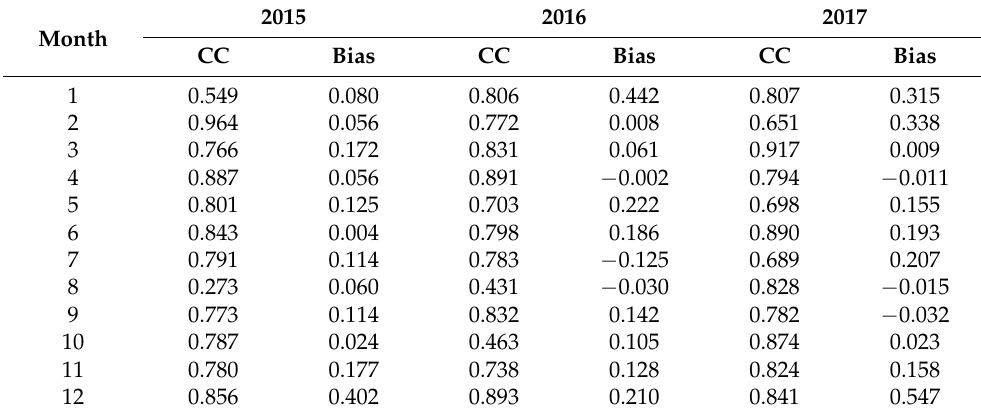
Table 1. Results of 36 months accuracy evaluation of the GWR-MF model.